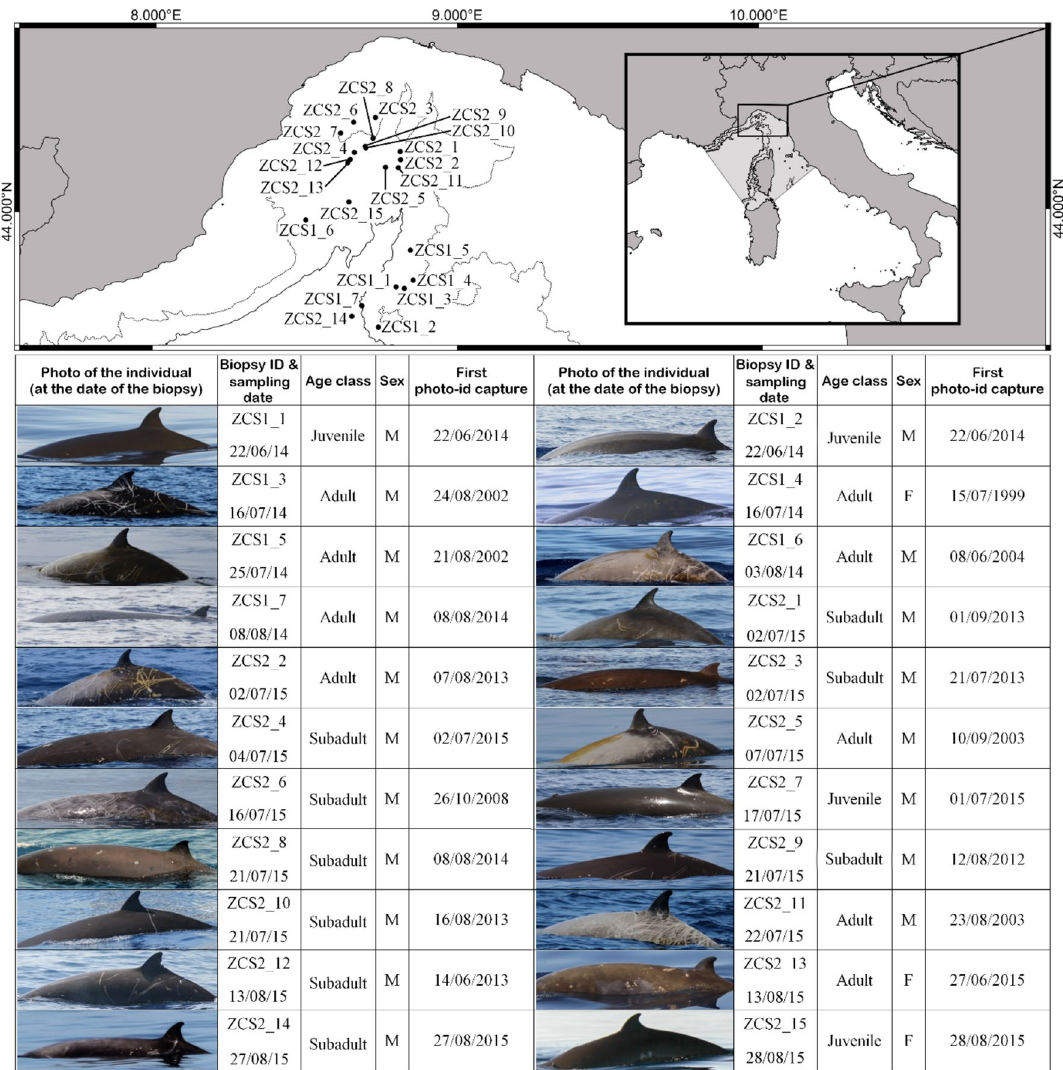
Figure 1. Map showing the study area, biopsy locations, the extent of the Pelagos Sanctuary, photos of sampled individuals, and information about sampling date, age class and their first photographic capture (Photos by M. Rosso). Map was generated using QGIS Geographic Information System (Version 3.10.10 ’A Coruña’; Open Source Geospatial Foundation.